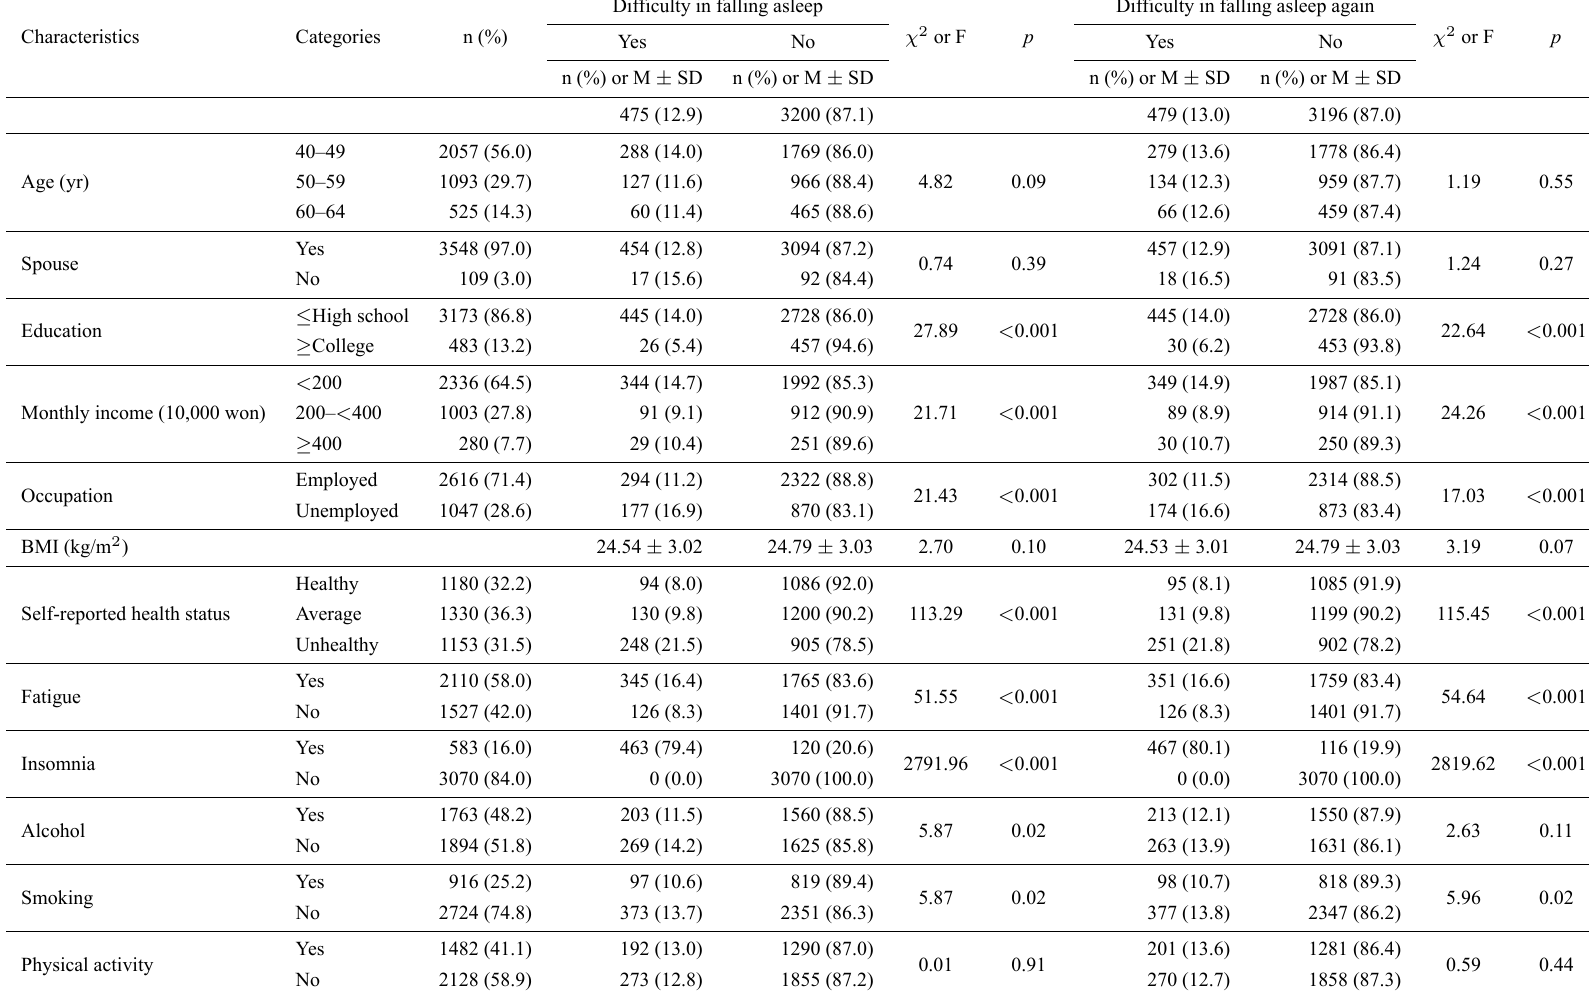
Table 2. Sleep disorder according to participants’ characteristics (n =